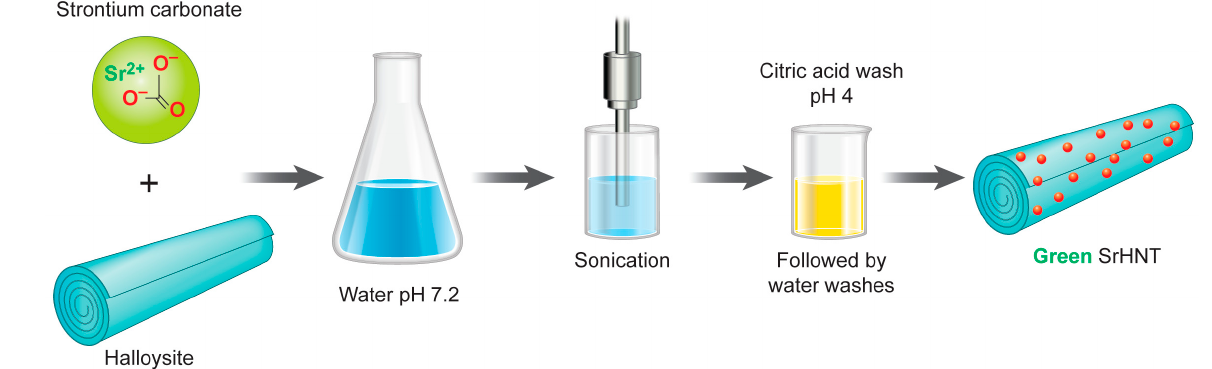
Figure 1. Schematic representation of the process for fabricating SrHNTs.